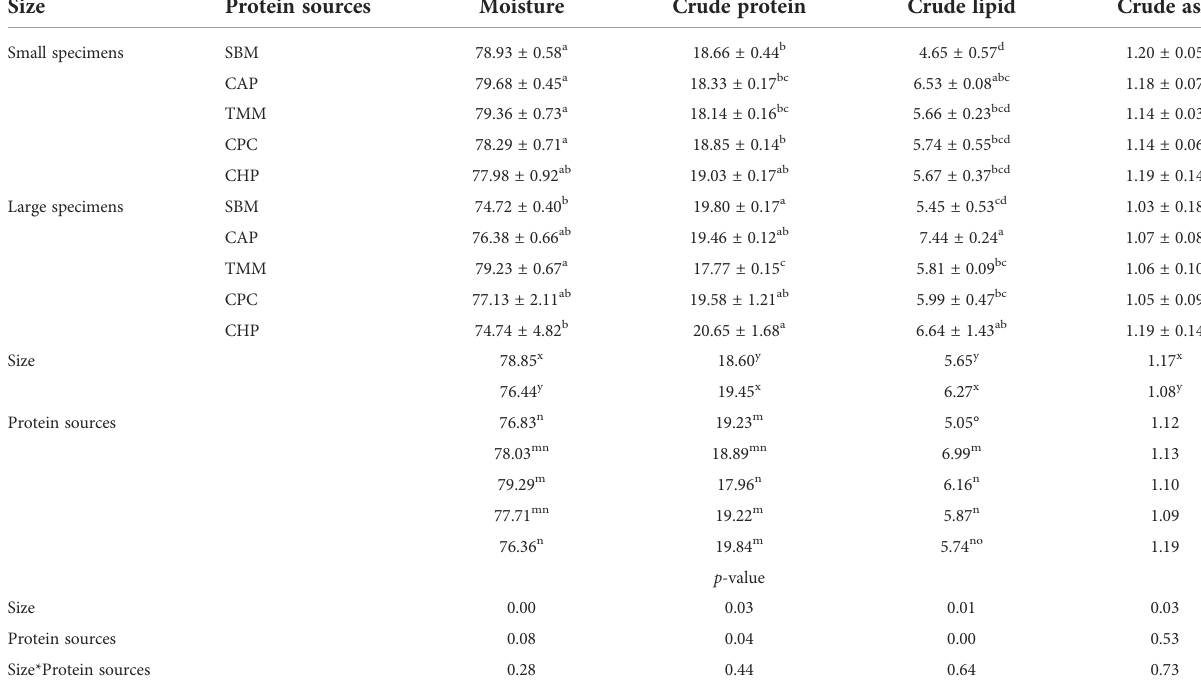
TABLE 5 Proximate composition of grass carp muscles in different